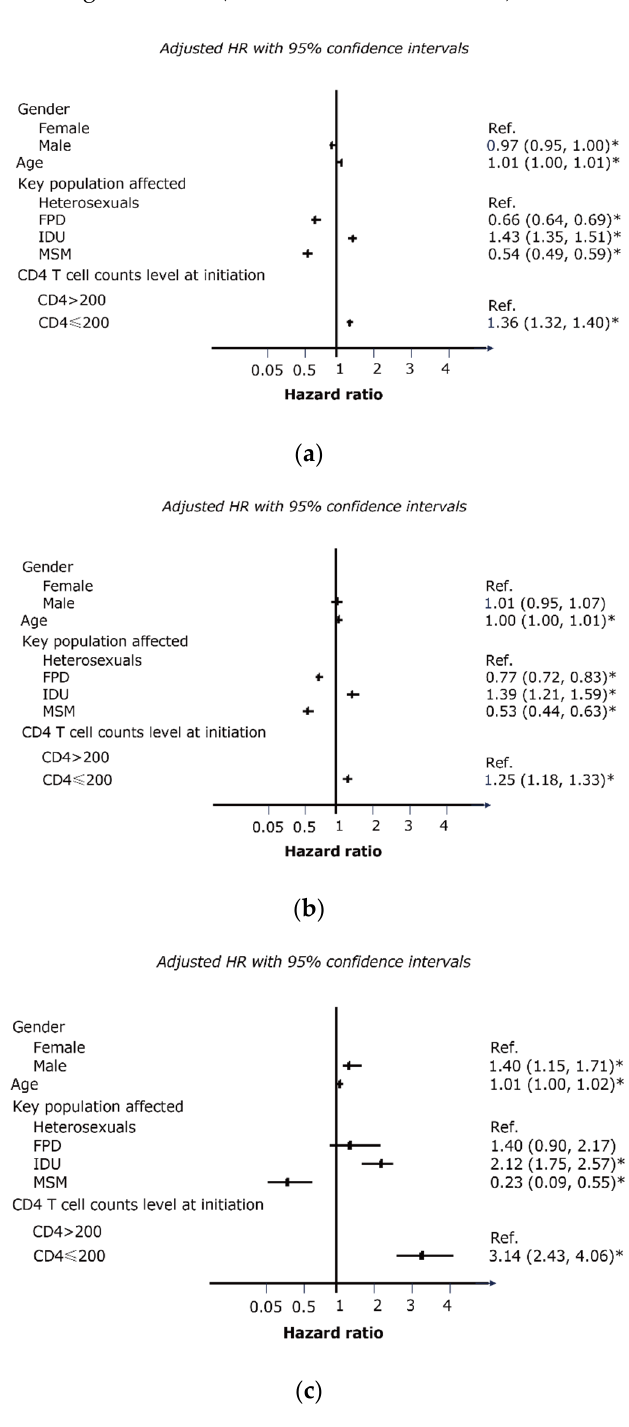
Figure 3. ( a ) Significant hazard factors associated with immunological failure due to HIV infections by cox regression analysis; ( b ) Significant hazard factors associated with virological rate due to HIV infections by cox regression analysis; ( c ) Significant hazard factors associated with HIV-related mortality, by cox regression analysis.